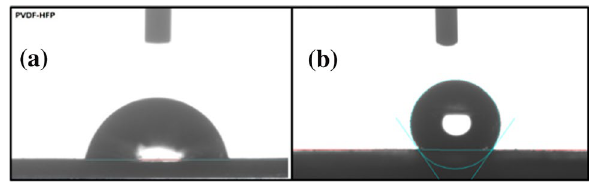
Fig. 6 ( a ) contact angle of PVDF-HFP and ( b ) CA of composite membrane (30-CNM/PAC)